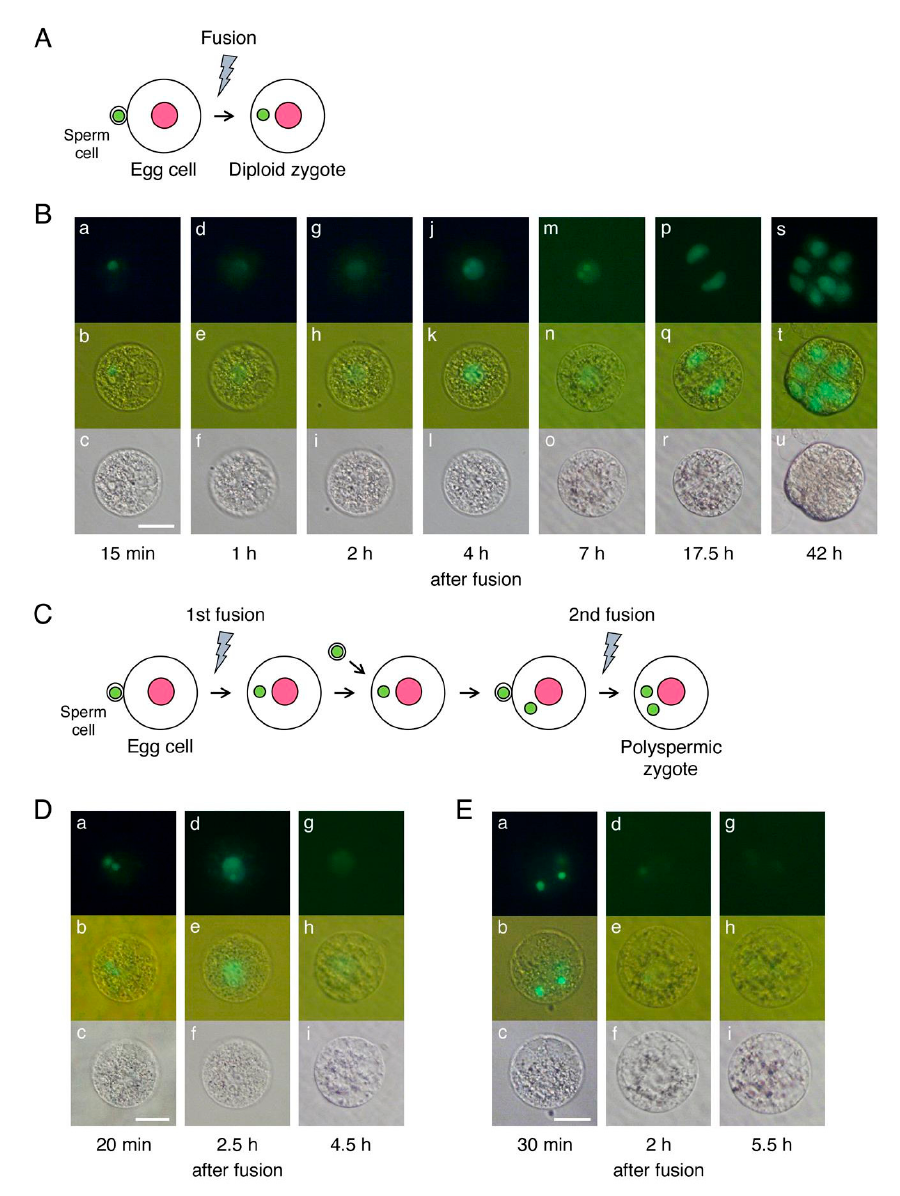
Figure 1. Developmental profiles of a diploid zygote ( A , B ) and polyspermic zygotes ( C – E ). ( A ) Schematic illustration of the production of diploid rice zygotes. An egg cell and a sperm cell were fused to produce a monospermic diploid zygote. ( B ) Developmental profiles of a diploid rice zygote. A sperm nucleus fluorescently labeled with H2B-GFP was observed in the zygote (a–c) and karyogamy progressed in the zygote (d–l). Thereafter, the zygote developed into a two-celled embryo (m–r) and a globular-like embryo (s–u). ( C ) Schematic illustration of the production of polyspermic rice zygotes. Two sperm cells were sequentially fused to an egg cell to produce a polyspermic zygote as described by Toda et al. (2016) [28]. ( D ) Progression of karyogamy in polyspermic zygotes. Two sperm nuclei fluorescently labeled with H2B-GFP were detected in the polyspermic zygote at 20 min after the fusion (a–c). The two nuclei then fused with an egg nucleus, resulting in a detectable zygotic nucleus (d–i). ( E ) Lack of karyogamy in polyspermic zygotes. Although two sperm nuclei fluorescently labeled with H2B-GFP were observed in the fused egg cell (a–c), the progression of karyogamy was undetectable (d–i). Pink and green circles in ( A , C ) indicate the egg and sperm nuclei, respectively. The gray flash symbols in ( A , C ) represent electro-fusions. Top, middle, and bottom panels in ( B , D , E ) represent fluorescent, merged fluorescent/bright-field, and bright-field images, respectively. Scale bars = 20 µ